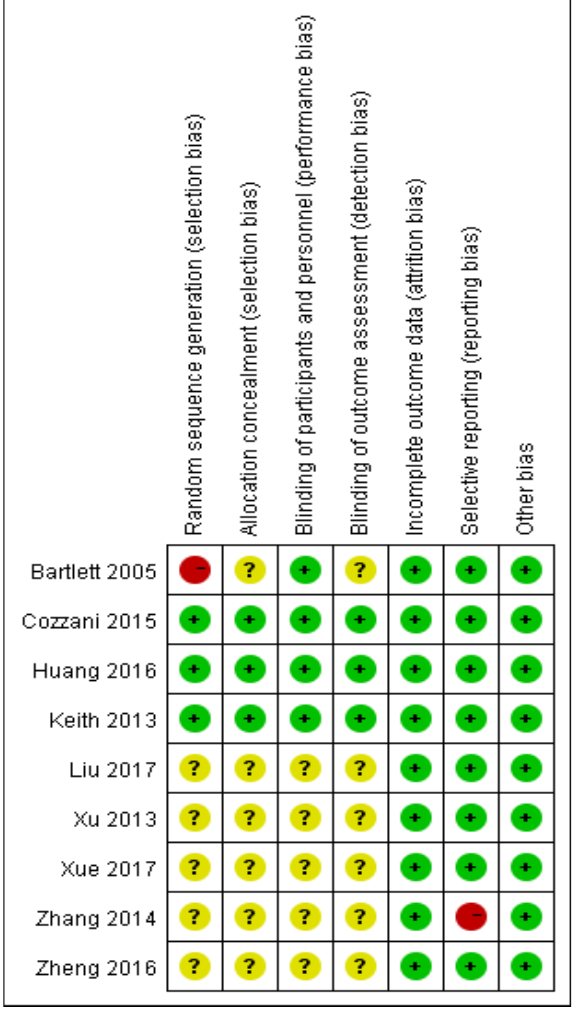
Figure 2. Risk of bias graph: review of the author’s judgment about each risk of bias item presented as percentages.